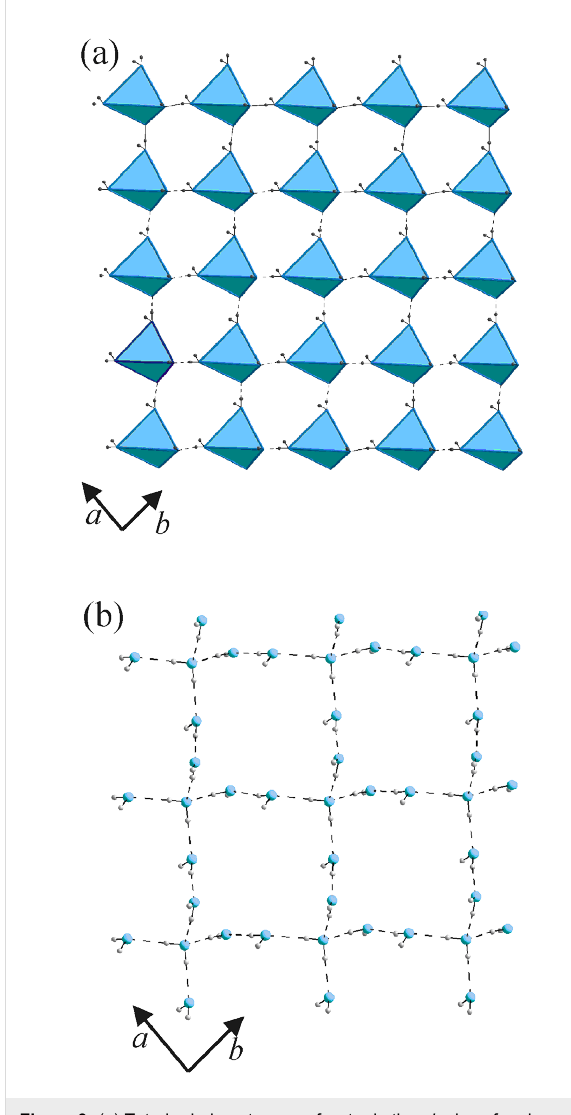
Figure 9: (a) Tetrahedral pentamers of water in the ab plane forming a nearly square arrangement (b) Hydrogen bonded network in the water layer.